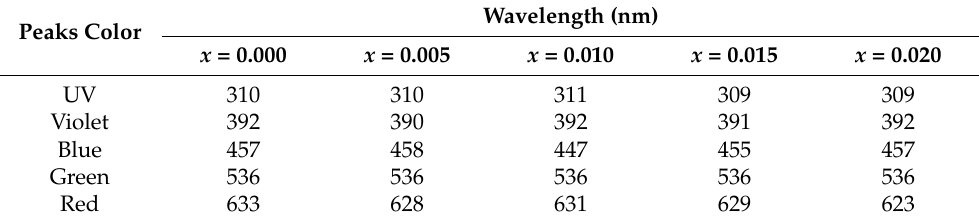
Table 2. MIC and MBC of the undoped and Mg-doped (Cu 1 − x Mg x O) NPs against four bacterial isolates.